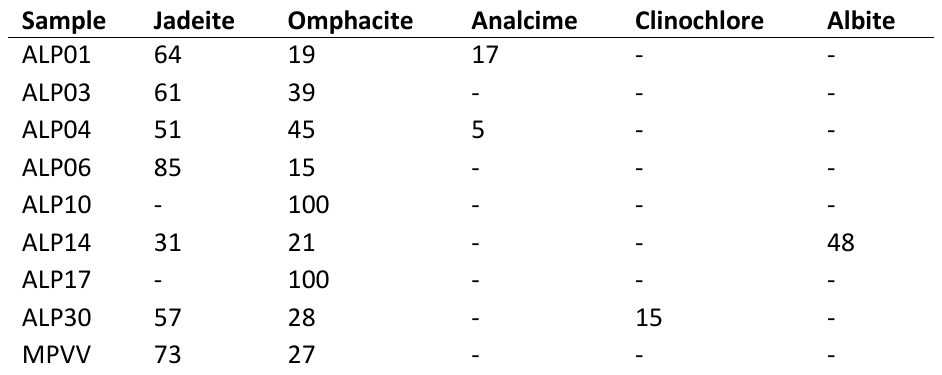
Table 2. Mineralogical semi-quantification obtained from X-Ray Diffraction. Besides, optical analysis revealed the presence of garnets (deformed garnets or hollow-core small garnets) in both the archaeological and geological samples. Produced by O.